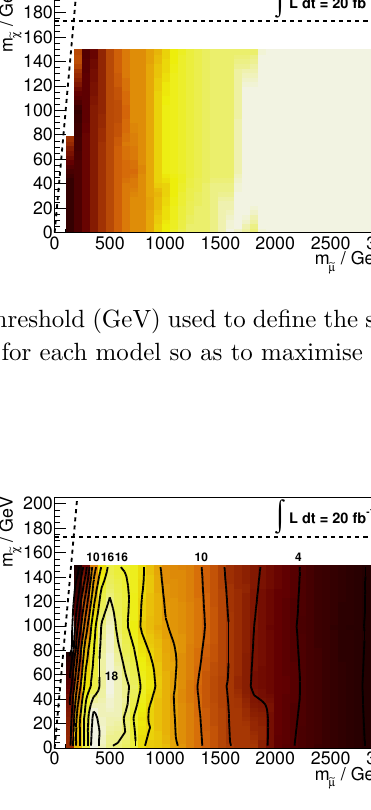
Figure 5. The median value of f (in e(cid:11)ect the expected sensitivity of the method) for the grid of (cid:21) 0 = 1 signal models. Recall that this f statistic (unlike the bin-wise f statistics of (cid:12)gure 2) 231 aggregates all events with m T ( (cid:22); =p ) greater than the model-dependent threshold shown in (cid:12)gure 4. T Contour lines show integer values of sensitivity.